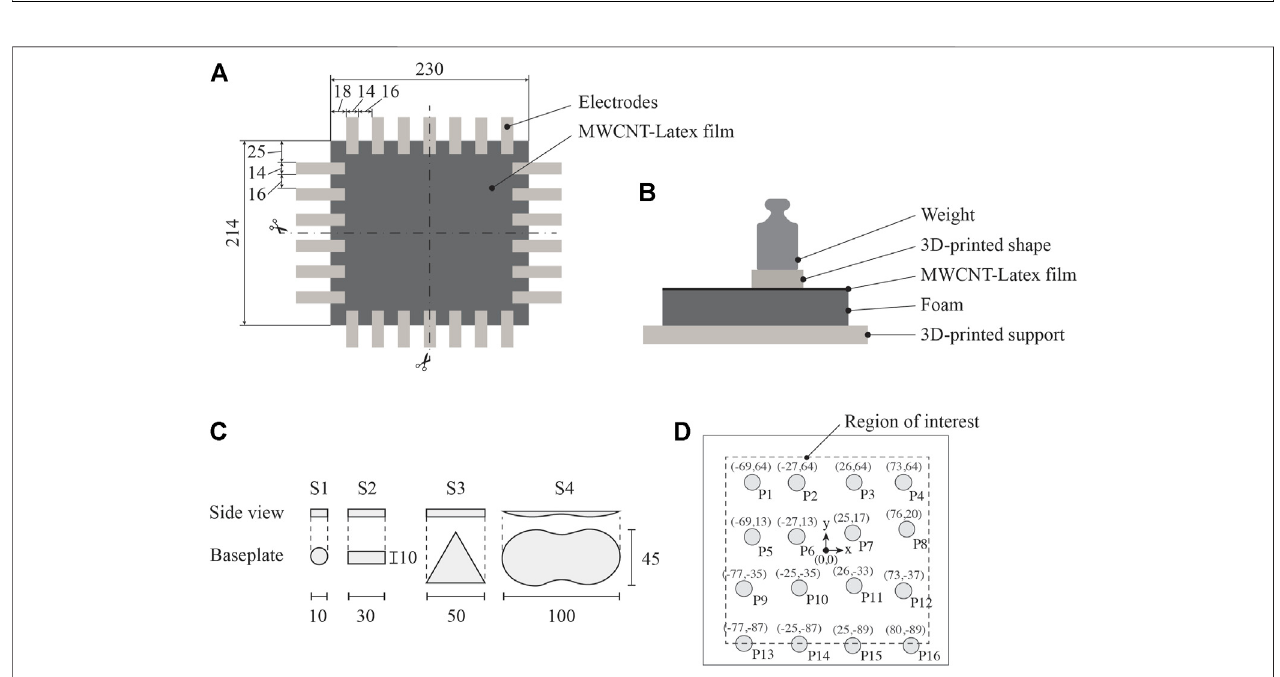
FIGURE 2 | (A) Schematic of the sensing specimen and ERT boundary electrodes (B) test setup for applying pressure hotspots (C) 3D-printed shapes to control contact area; and (D) location of hotspots and coordinates of their centers. All dimensions are shown in